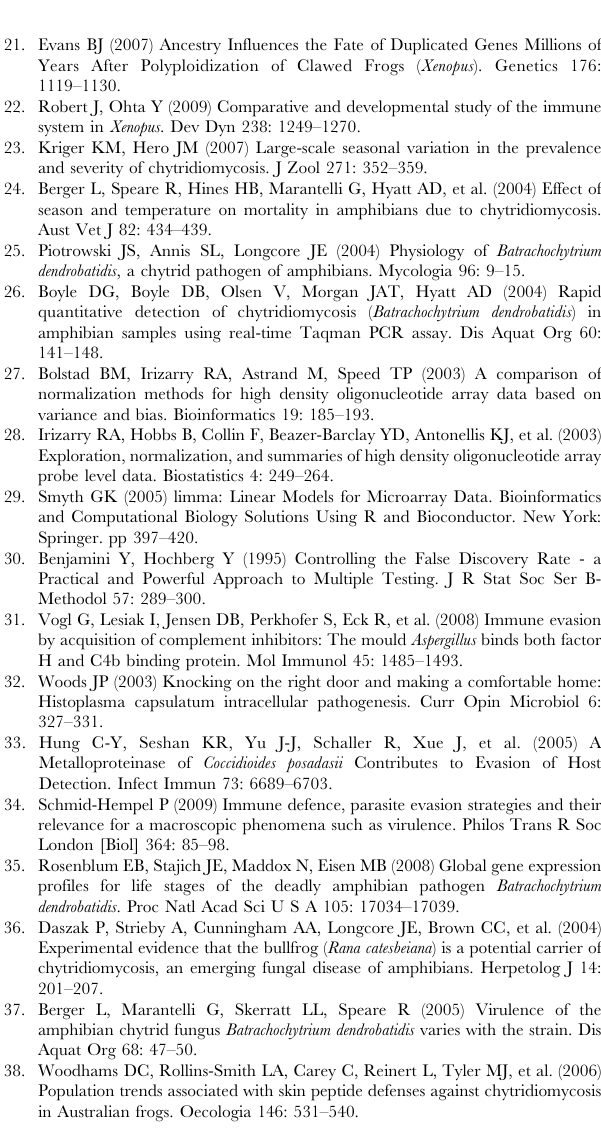
Table S1 Complete list of genes with significant differences in expression between naı¨ve and Bd -exposed frogs. Table columns correspond to gene identifiers (NimbleGen, Joint Genome Institute, and Ensembl), number of probes in probe set,